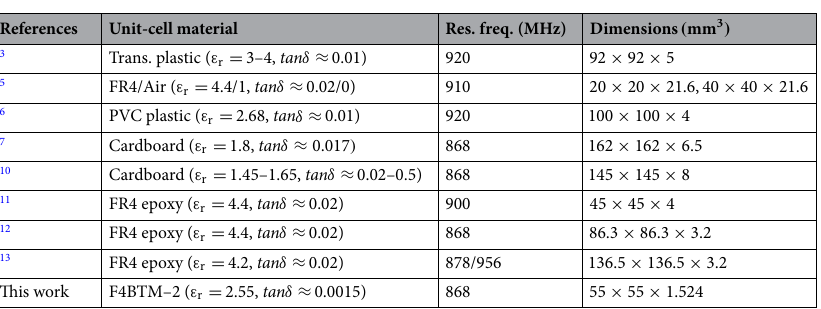
S 11 results of the unit-cells derived from HFSS and ADS. | |